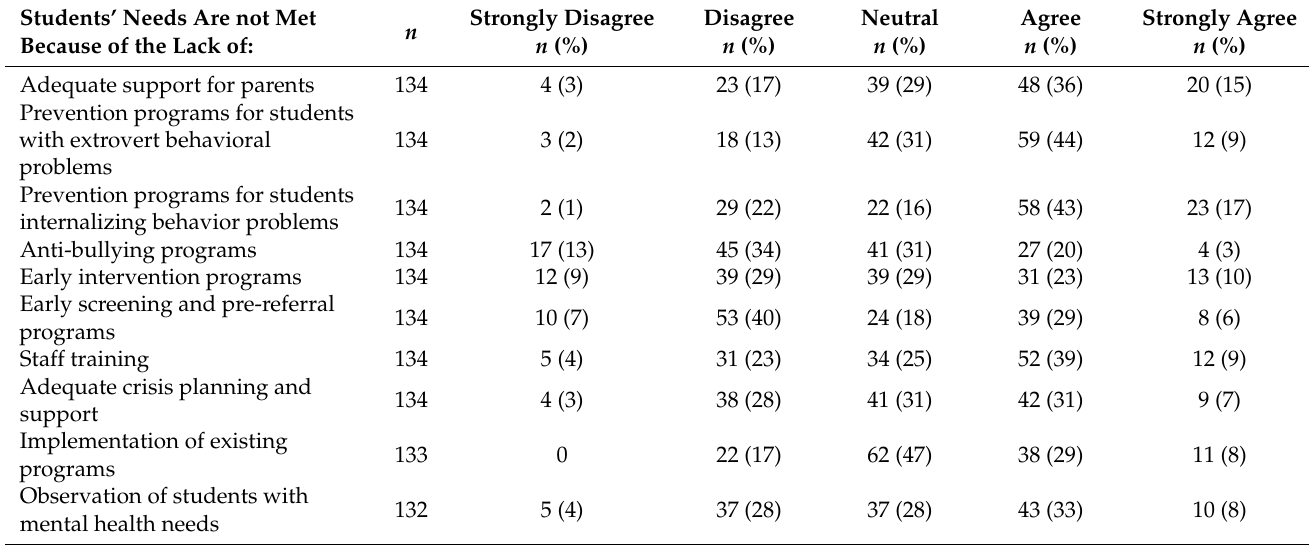
Table 4. Reasons for students not getting help and barriers for mental health services in